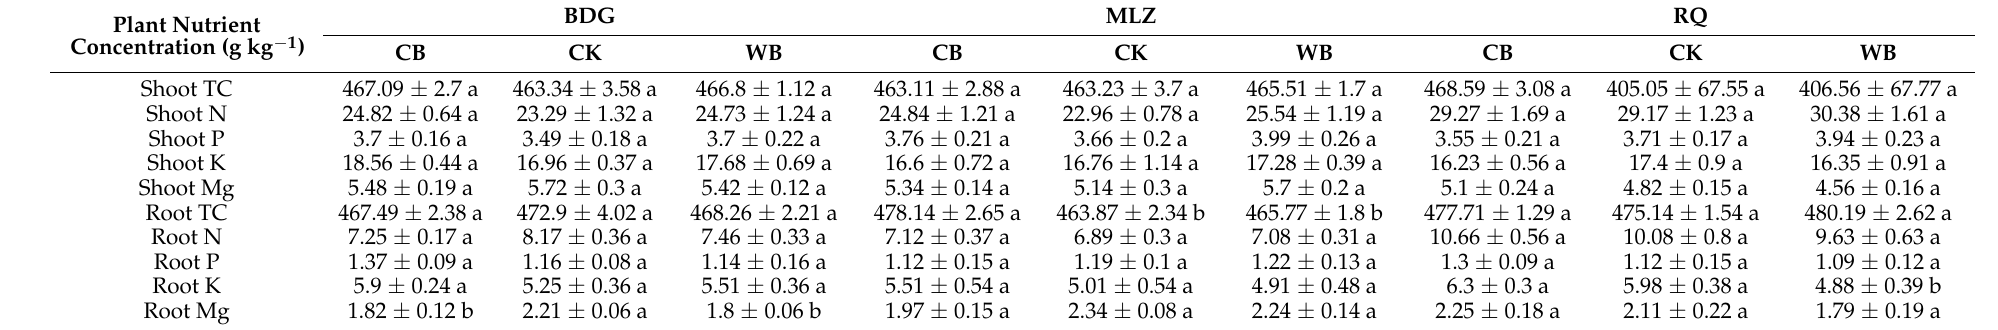
Table 2. Plant nutrient concentrations under treatment of biochar in sandy clay loam (BDG and MLZ) and silty clay loam (RQ) soils. Plant Nutrient Concentration (g kg − 1 )